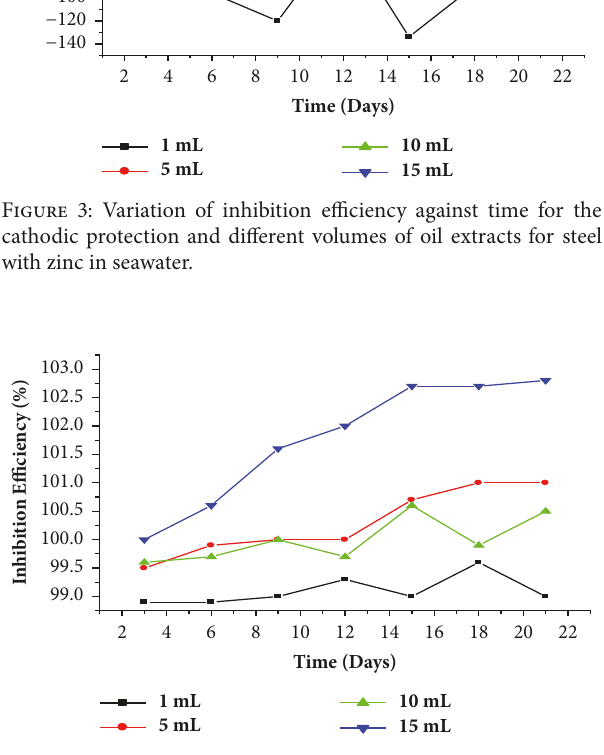
Figure 4: Variation of inhibition efficiency against time for the cathodic protection and different volumes of oil extracts for steel with zinc in 0.1M sulphuric